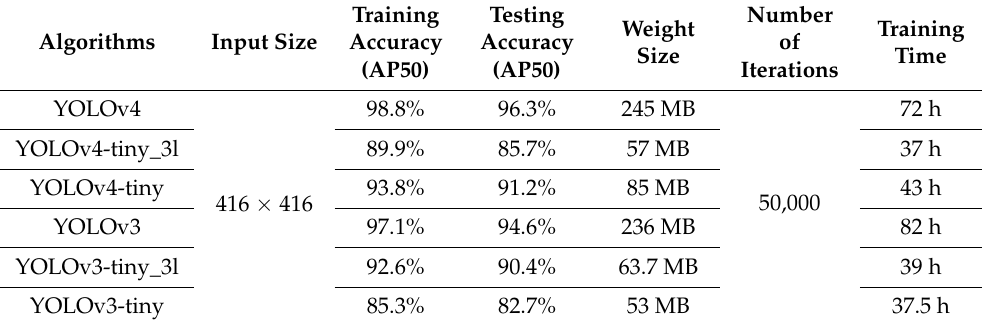
Table 6. Comparison of all YOLO networks based on a large dataset.